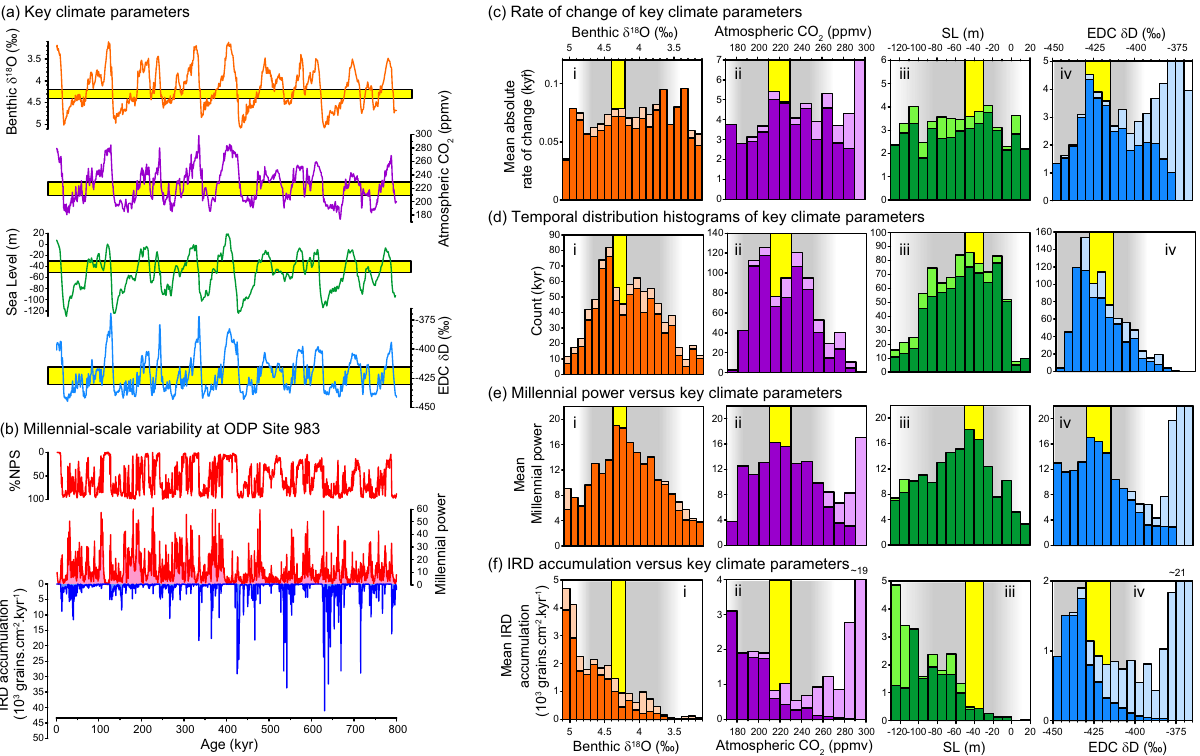
Fig. 2 The sweet spot of millennial variability. a Records of benthic δ 18 O 65 , atmospheric CO 2 97 , sea level 93 and Antarctic δ D 98 . Yellow bars are same as for c – f . b Records from ODP Site 983 25 : %NPS (a proxy for sea surface temperature), millennial power (Hilbert transform of the 0.5 – 7 kyr Taner bandpass fi ltered %NPS record) and Ice Rafted Debris (IRD) accumulation. c Binned mean absolute rates of change for the records in a . d Distribution histograms of the records in a . e Mean millennial power for the same bins utilized in c , d . f Mean IRD accumulation rates for the same bins utilized in c , d . In each panel fainter colours represent deglacial intervals (terminations) while bolder colours represent all other times. Yellow bars highlight the respective peaks in millennial power in e (the sweet spot as described in the text and Box 1) and grey shaded regions highlight the broader windows of